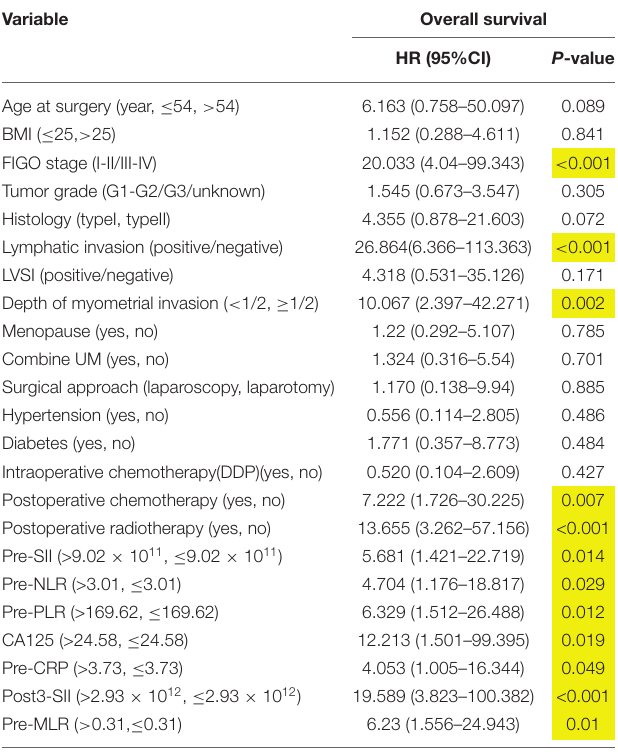
TABLE 3 | Univariate analysis of patient survival ( n = 246).